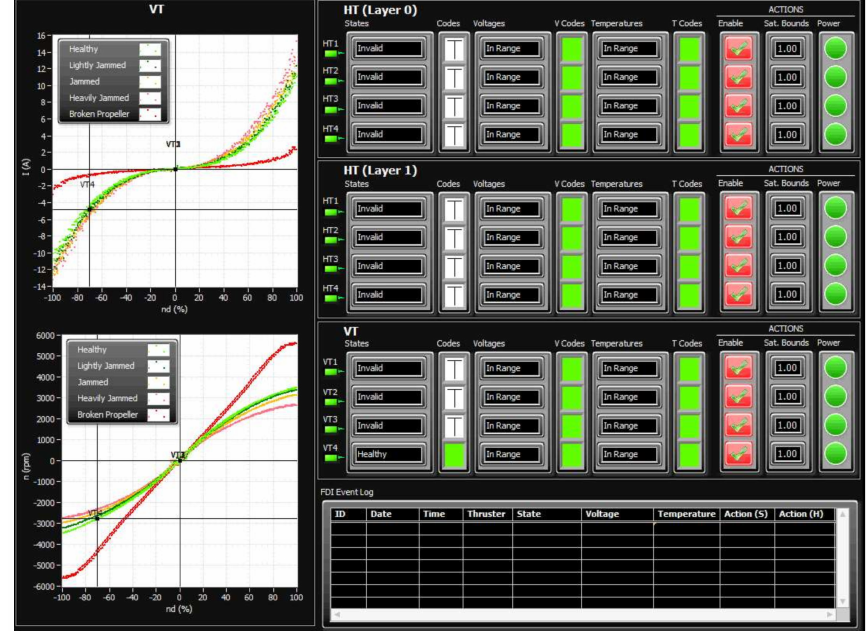
Figure 16. Thruster FDI result for thruster state =